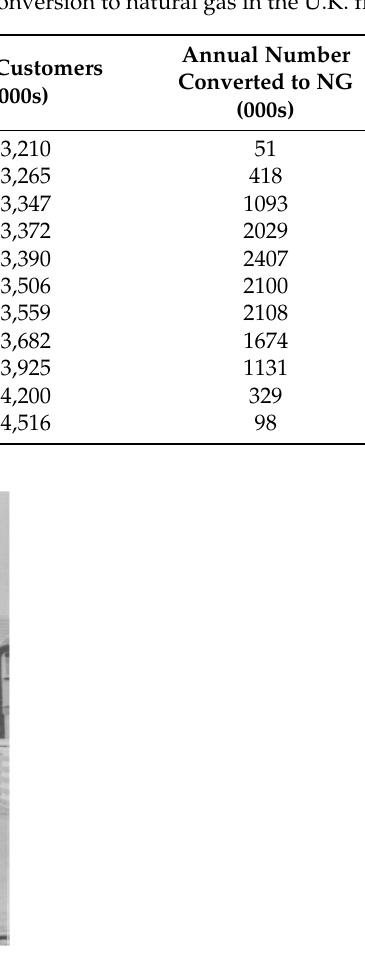
Table 4. Progress of the customer conversion to natural gas in the U.K. from the 1960s to the 1970s.